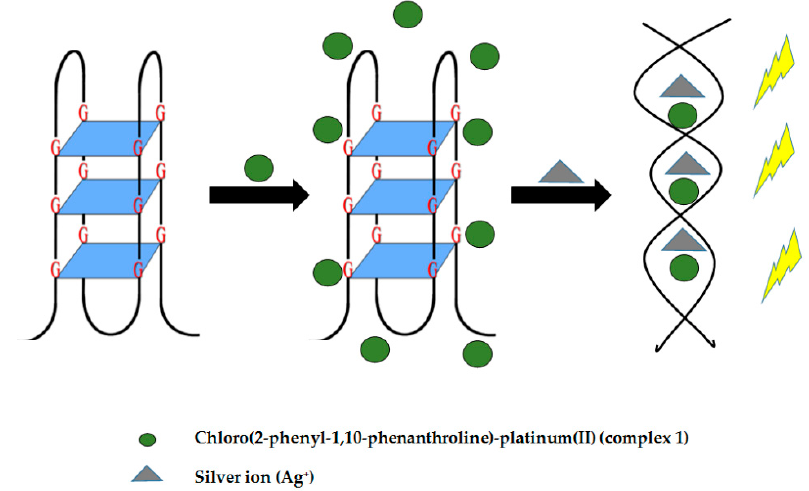
Figure 19. A schematic illustration of luminescence-based G-quadruplex assay for aqueous silver ions detection. ( a )The initial structure of G-quadruplex. ( b ) The poor interaction of G-quadruplex and complex 1. ( c ) The silver ions induce the G4-to-duplex conformational change, allowing the intercalation of complex 1 and resulting in the emission of intense phosphorescence.